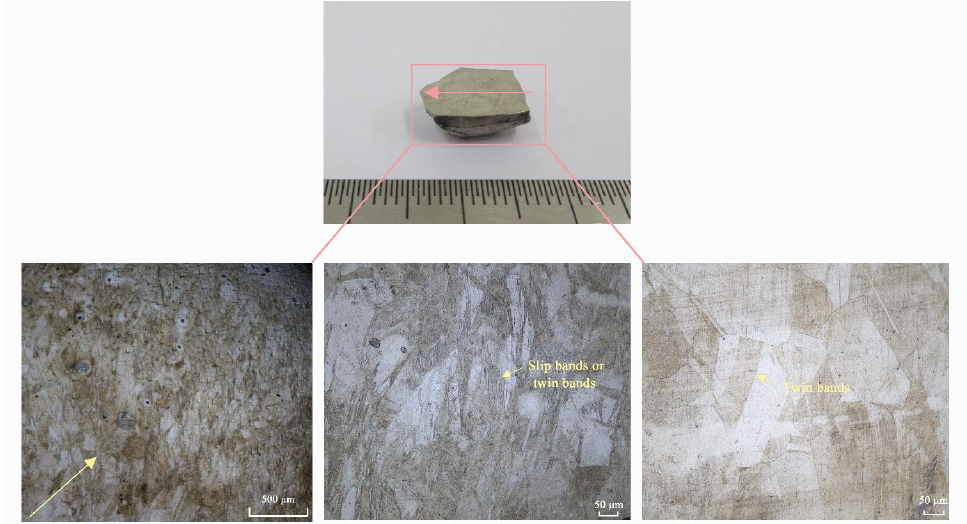
Figure 18. Optical microscopy (OM) images of the initial FeNiCoCr HEA LRP, v = 1136 m/s.